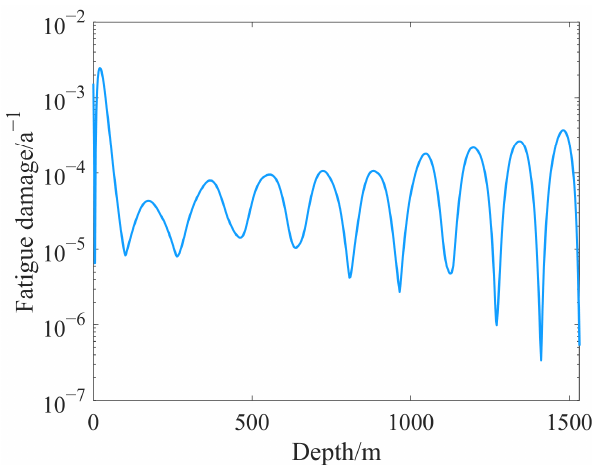
Figure 7. Riser fatigue damage.